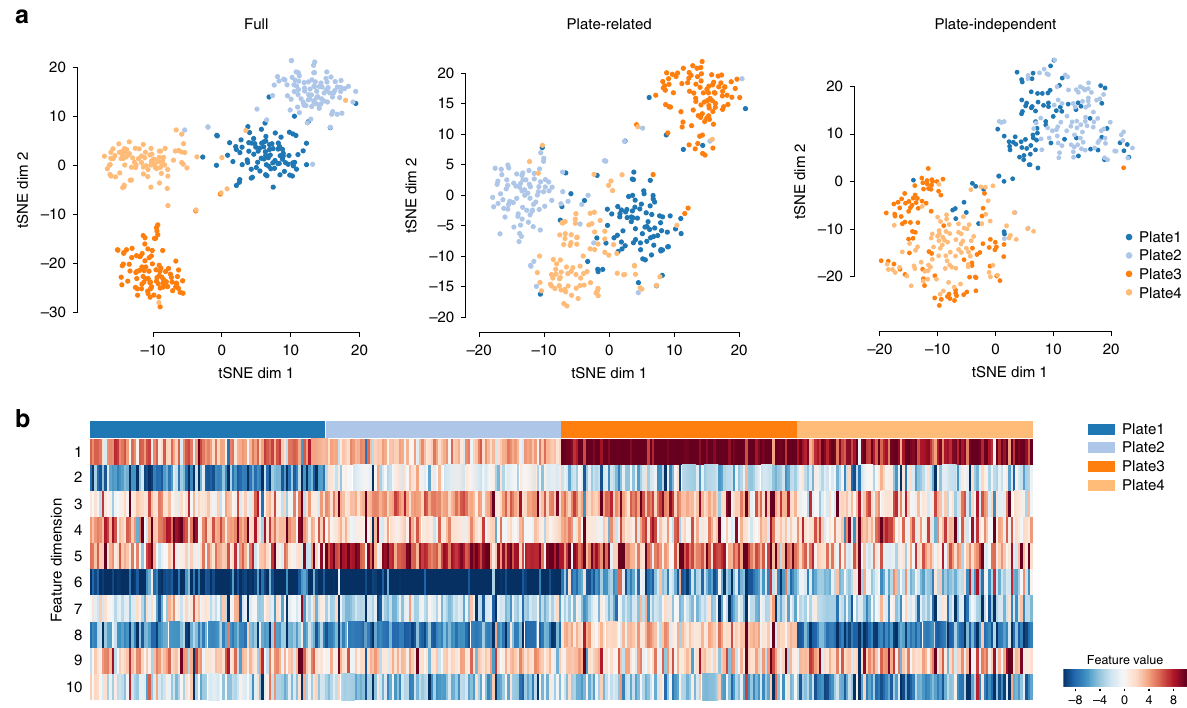
Fig. 5 Batch effects and biological cell types are captured by disentangled latent features. a t -SNE visualization of full features, plate-related features (features 2, 3, 4, 5, 8, 10), and plate-independent features (features 1, 6, 7, 9). b Heatmap of the ten features learned by SCALE. Different batches (plates) are colored by different colors on the top, plate 1 and 2 are Epcam + cells, plate 3 and 4 are CD45 + cells